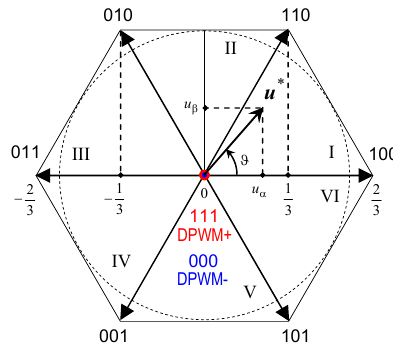
Figure 1. Output voltage space vector diagram and sectors (normalized by V dc ).